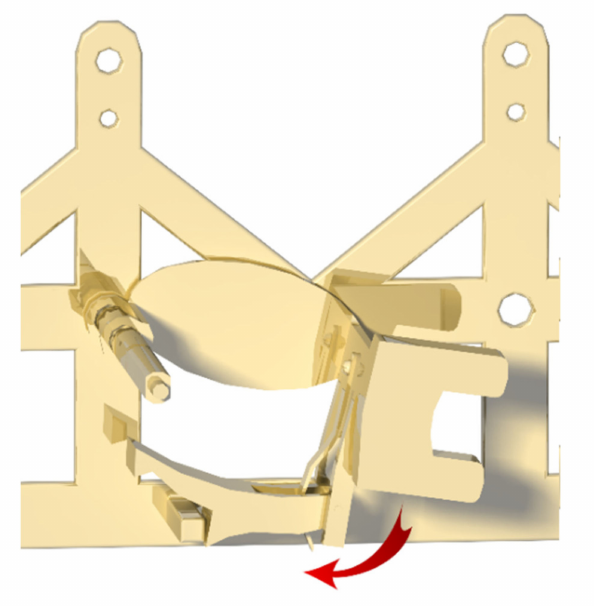
Figure 15. Falling movement of the carry mechanism in its final position with contact at the top of the structure.